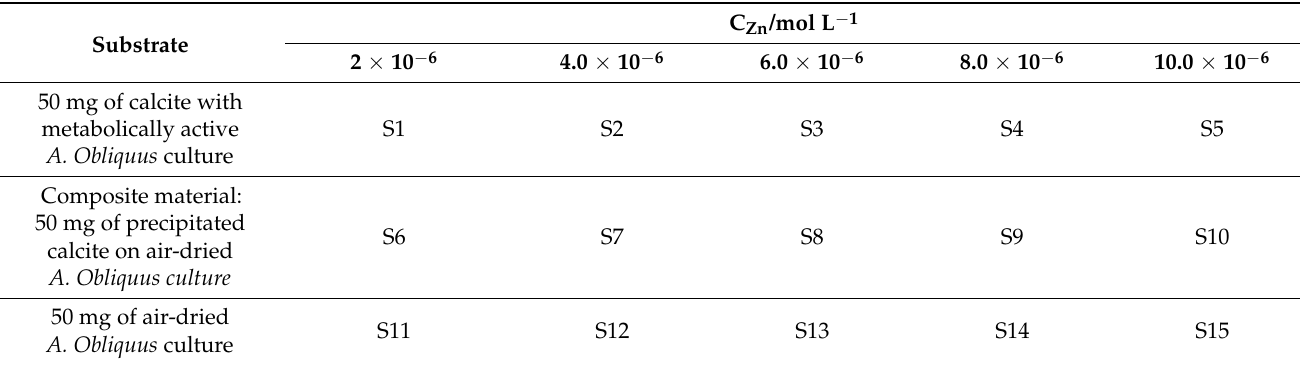
Table 10. Zinc adsorption in solutions saturated with respect to calcite on different substrates. Substrate, initial zinc concentration and the corresponding substrate solution code name. Temperature of 25 ◦ C, pH 8.50, 0.15 M of